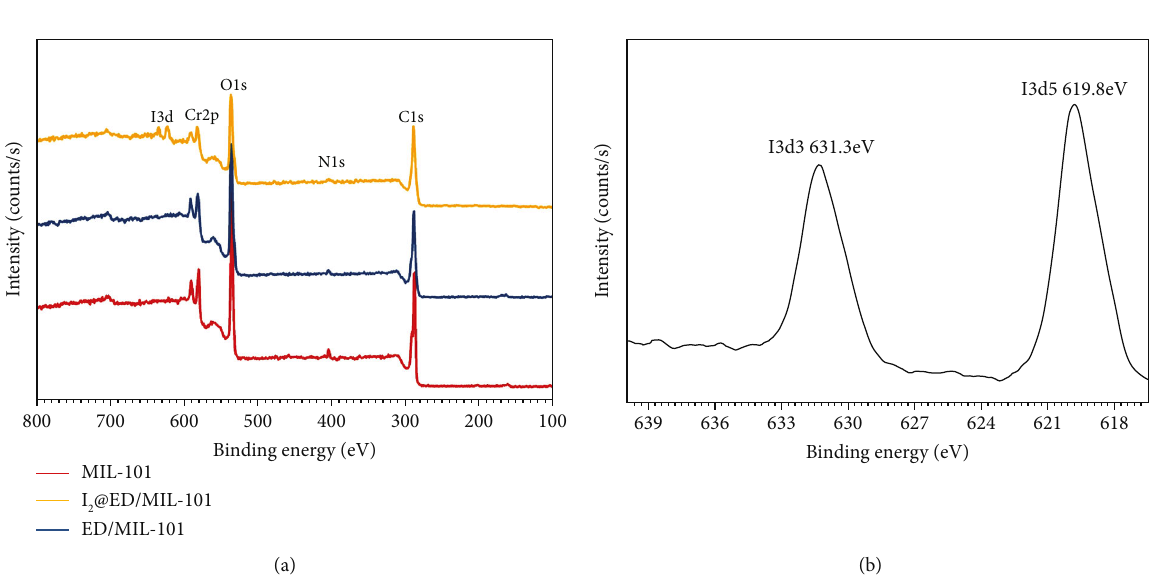
Figure 8: X-ray photoelectric spectroscopy. (a) Full energy spectrum. (b) Local energy